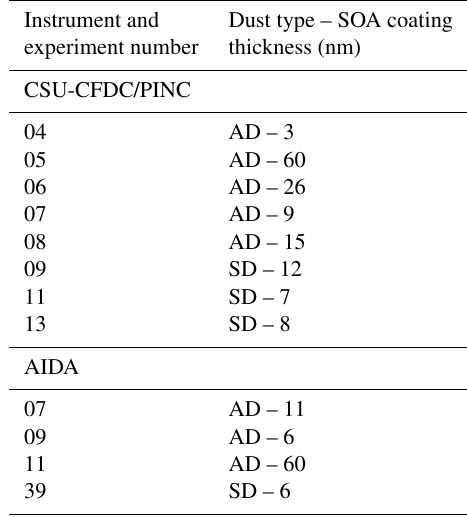
Table 1. Experiment number and corresponding SOA coating thick- ness calculated based on mass yield of SOA distributed equally over available dust surface area.